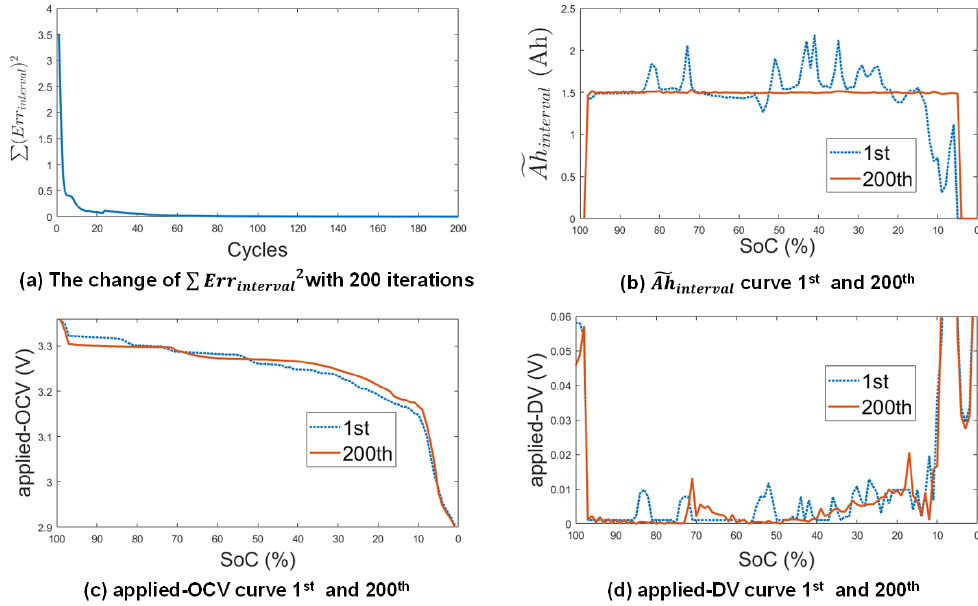
Figure 9. The change process of (cid:102) Ah interval /OCV curve/DV curve from 1st to 200th: ( a ) The change in ∑ ( Err ) 2 with 200 iterations; ( b ) 1st and 200th (cid:102) Ah interval curve; ( d ) 1st and 200th applied-DV